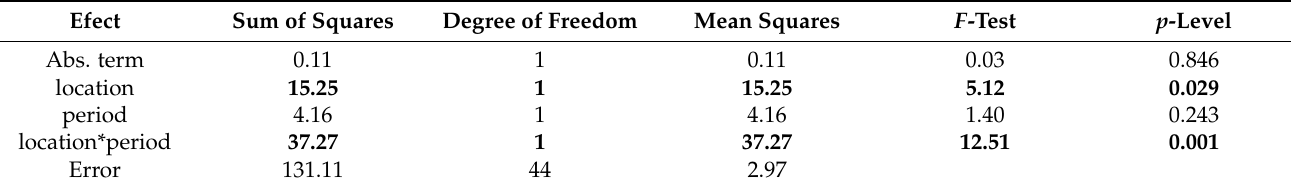
Table 4. One-dimensional test ANOVA for Schall 03.